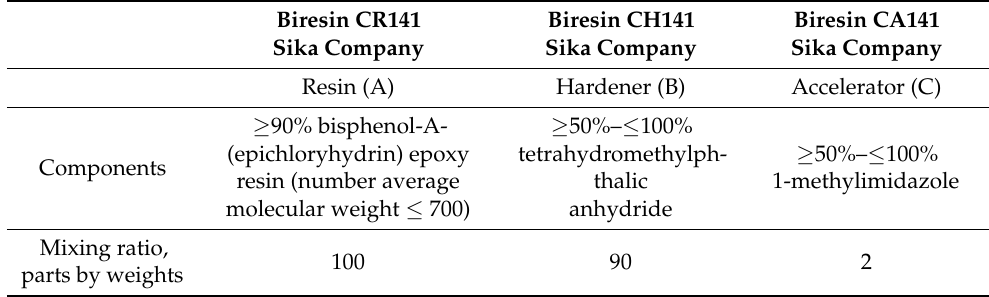
Table 1. Resin components.